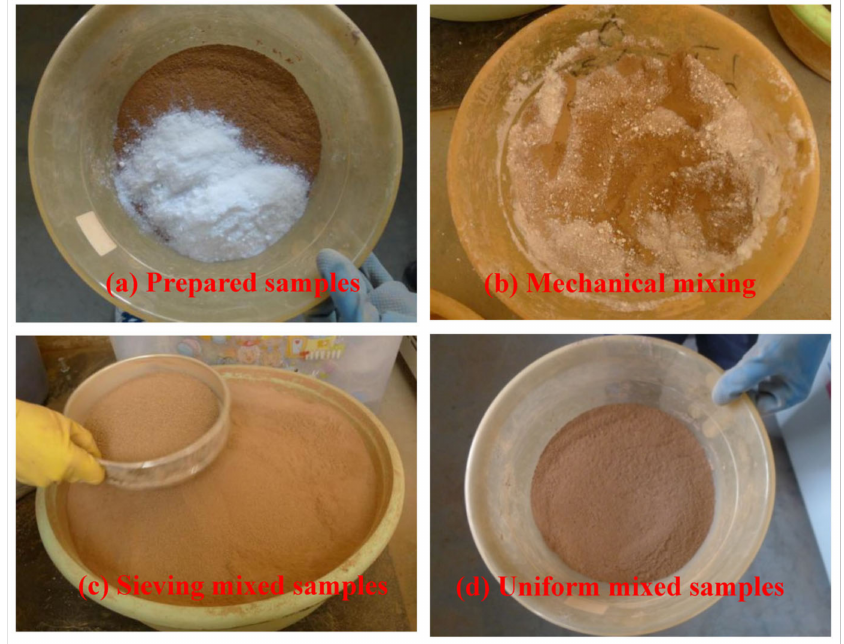
Figure 2. The mixing process of NS-modified silty